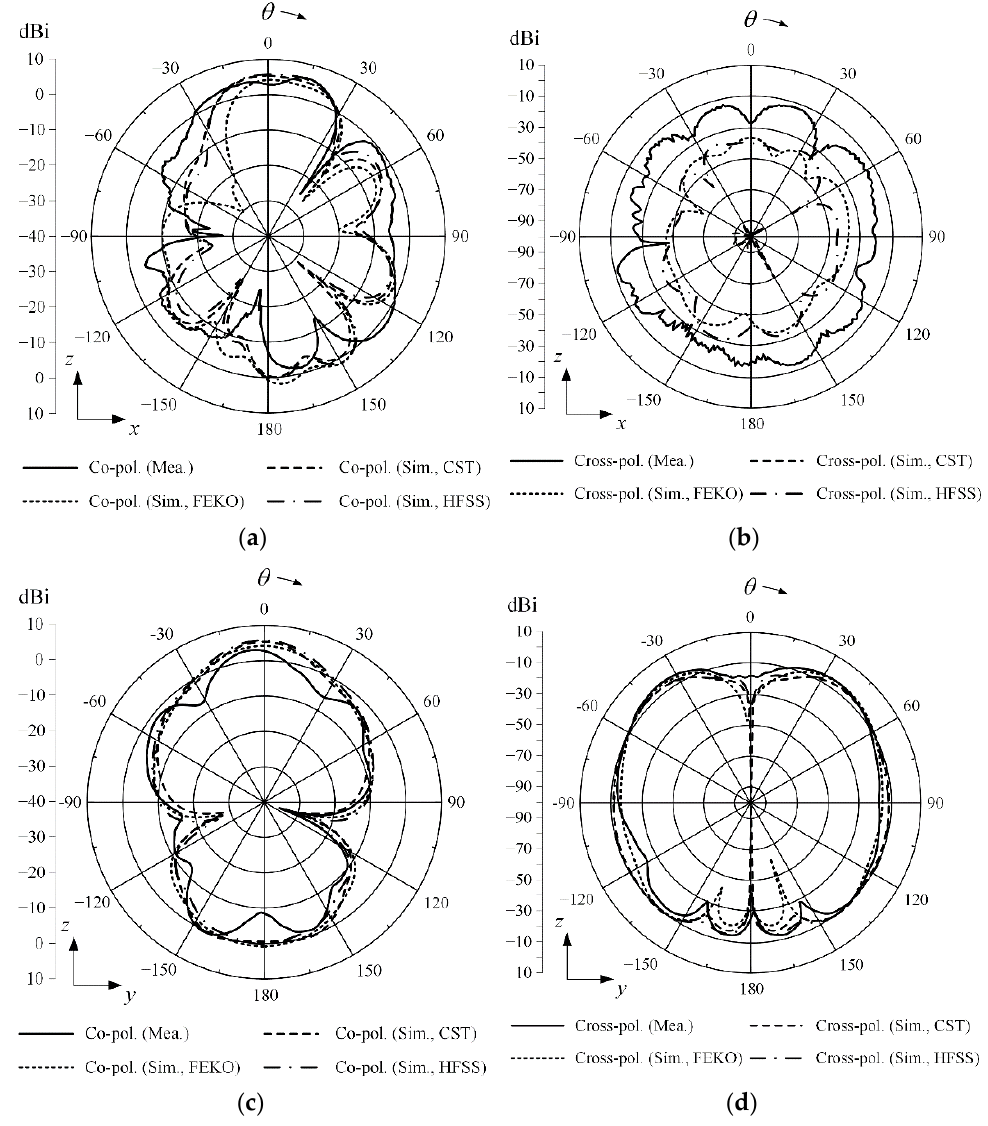
Figure 15. Measured and simulated 2-D radiation patterns of the proposed antenna at 28 GHz: ( a ) zx -plane co-polarization; ( b ) zx -plane cross-polarization; ( c ) zy -plane co-polarization; ( d ) zy -plane cross-polarization.